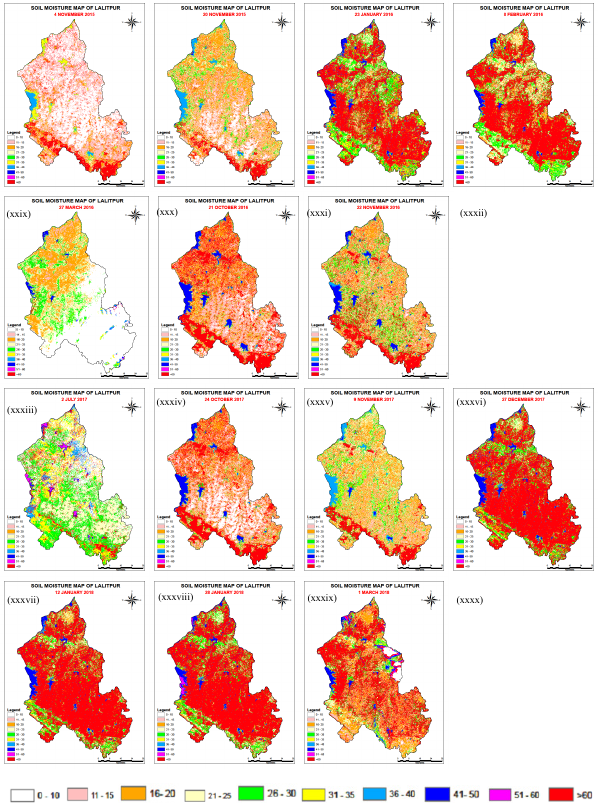
Figure 4 (i) to (xxxx): Soil moisture map of Lalitpur 2013-2018 By the above maps given from figure no 4 (i) to figure no 4 (xxxx),it can be seen that, the soil moisture content for the study area was categorized in 10 classes as; 0 to 10 to >60% because at 60% of moisture level the soils become over saturated.